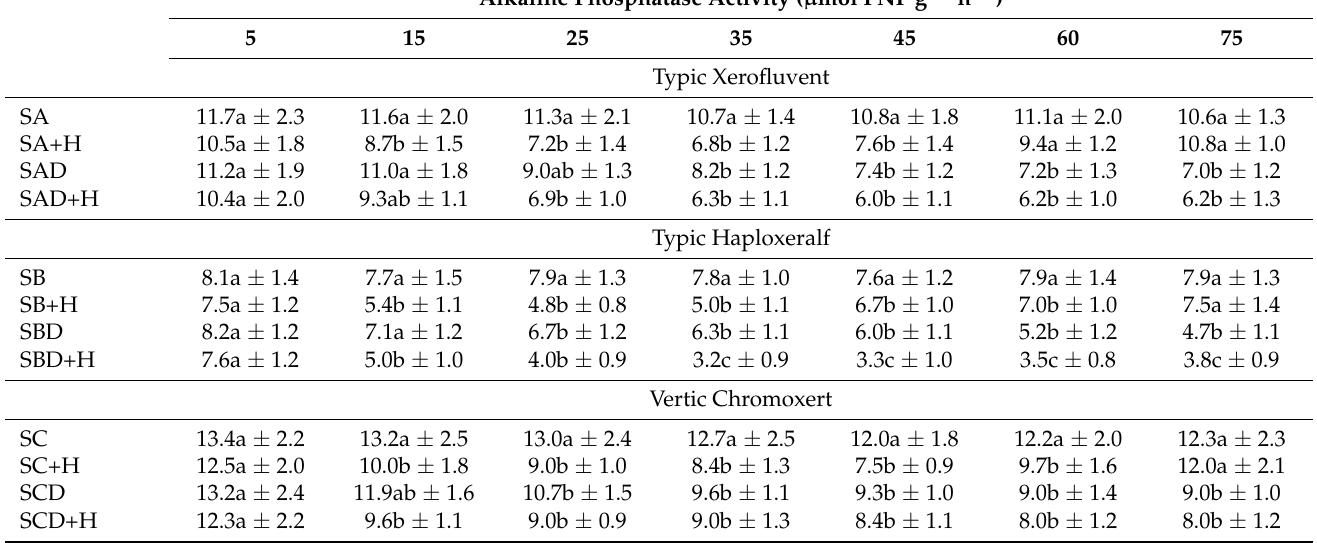
Table 5. Evolution of alkaline phosphatase activity (mean ± standard error, n = 3) in watered and non-watered soils with MCPA during the